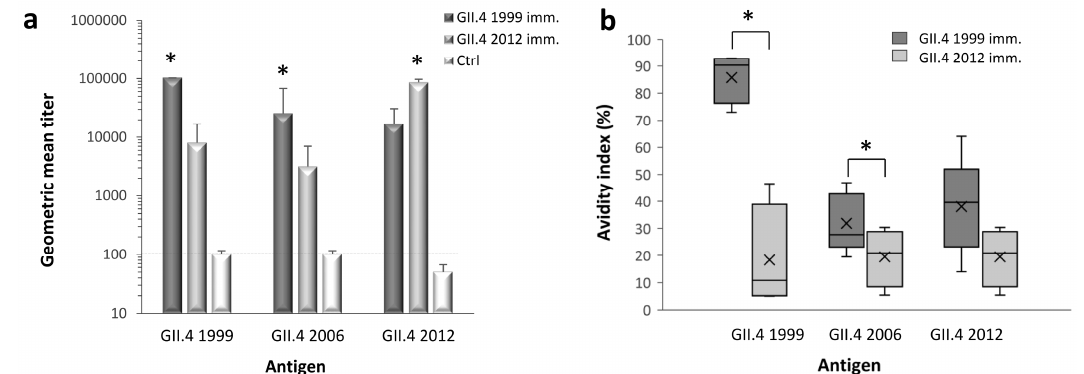
Figure 1. Titers and avidity of norovirus (NoV) type-specific and cross-reactive serum immunoglobulin G (IgG) antibodies. Mice were immunized with GII.4 1999 (5 mice) and GII.4 2012 (4 mice) virus-like particles (VLPs) and the immune sera was used in enzyme-linked immunosorbent assay (ELISA) to determine the magnitude of IgG antibodies against homologous and heterologous NoV VLPs ( a ). Serum of mice receiving phosphate buffered saline (PBS) (5 mice) was used as a negative control (Ctrl). Shown are the geometric mean titers (GMTs) with 95% confidence intervals (error bars) counted from individual mice end-point titers in each immunization group. The dashed line illustrates the cut-off titer for samples considered positive. The avidity of IgG antibodies was measured from individual mice sera against homologous and heterologous NoV VLPs ( b ) as described in the Material and Methods. Horizontal lines in the box plots represent the medians, cross-symbols ( × ) represent the means, and the boxes illustrate the interquartile range that contains 50% of values with whiskers extending to the highest and lowest values. The antigen-specific antibody titers and the avidity indexes between immunization groups were compared by the Kruskal–Wallis test and significant differences ( p value <0.05) are identified with an asterisk